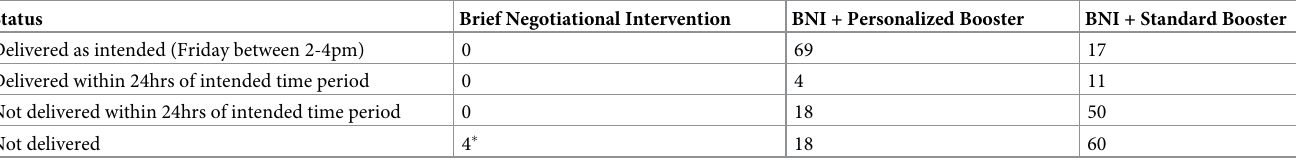
Table 6. SMS delivery status within the intended Friday 2-4pm time period, by arm.